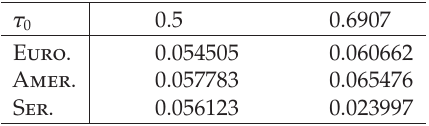
Table 2.8 . Put: Run 2; as in Table 2.7 but S = 0 . 04, and σ = 0 . D 0